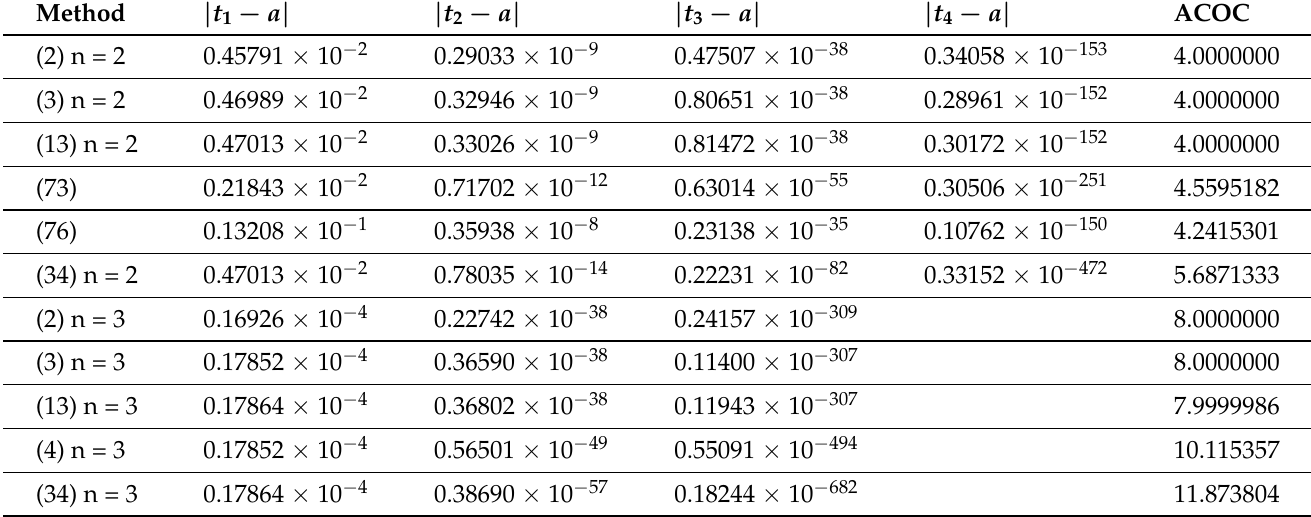
Table 9. Numerical results for f 4 ( t )